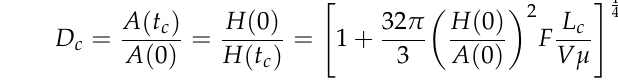
The fitting curve Experimental data